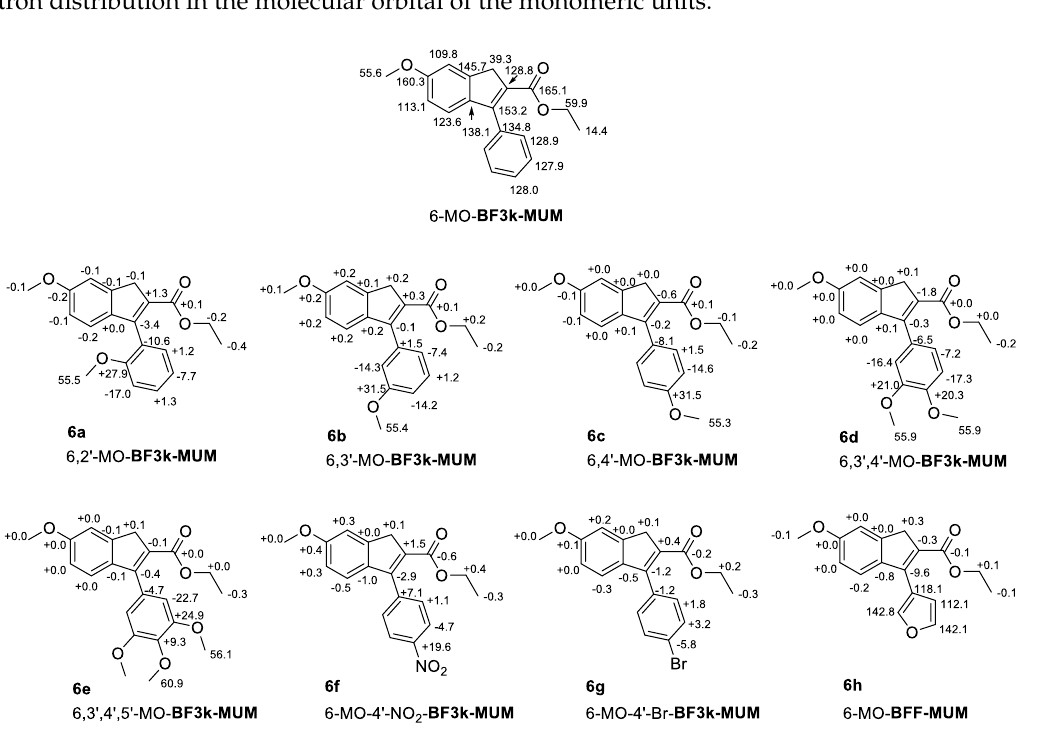
Figure 3. Effects of the pendant ring manipulation on the 13 C NMR chemical shift values of the model compounds 6a – h with respect to 6-MO- BF3k-MUM . compounds 6a – h with respect to 6-MO- BF3k-MUM